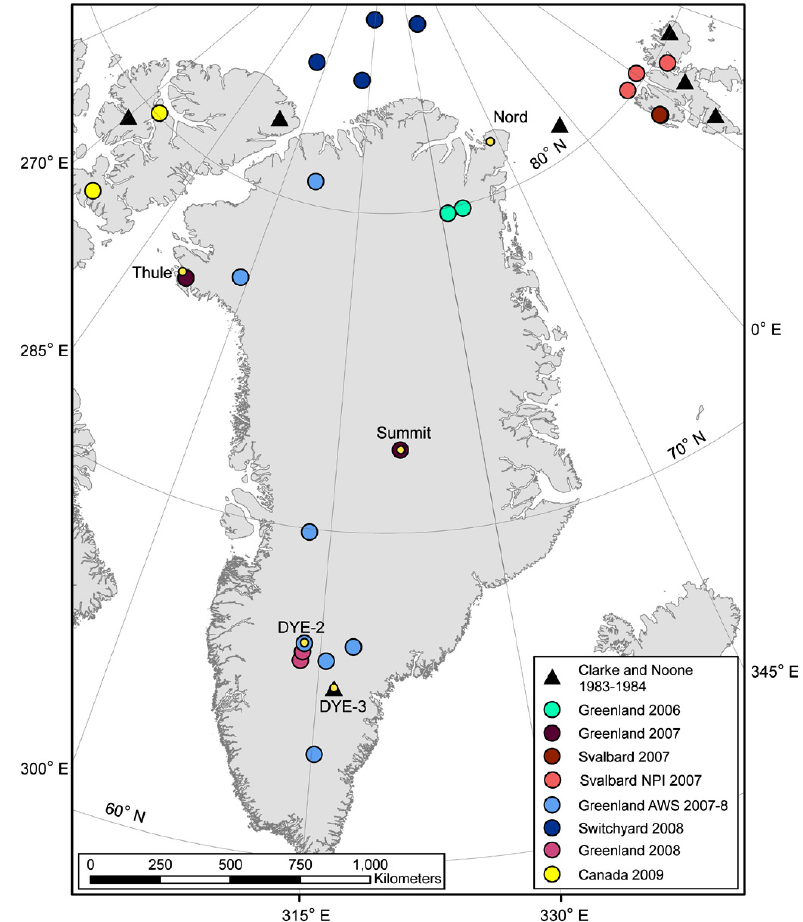
Fig. 4. Map showing sampling locations in Greenland (2006–2008) and vicinity.